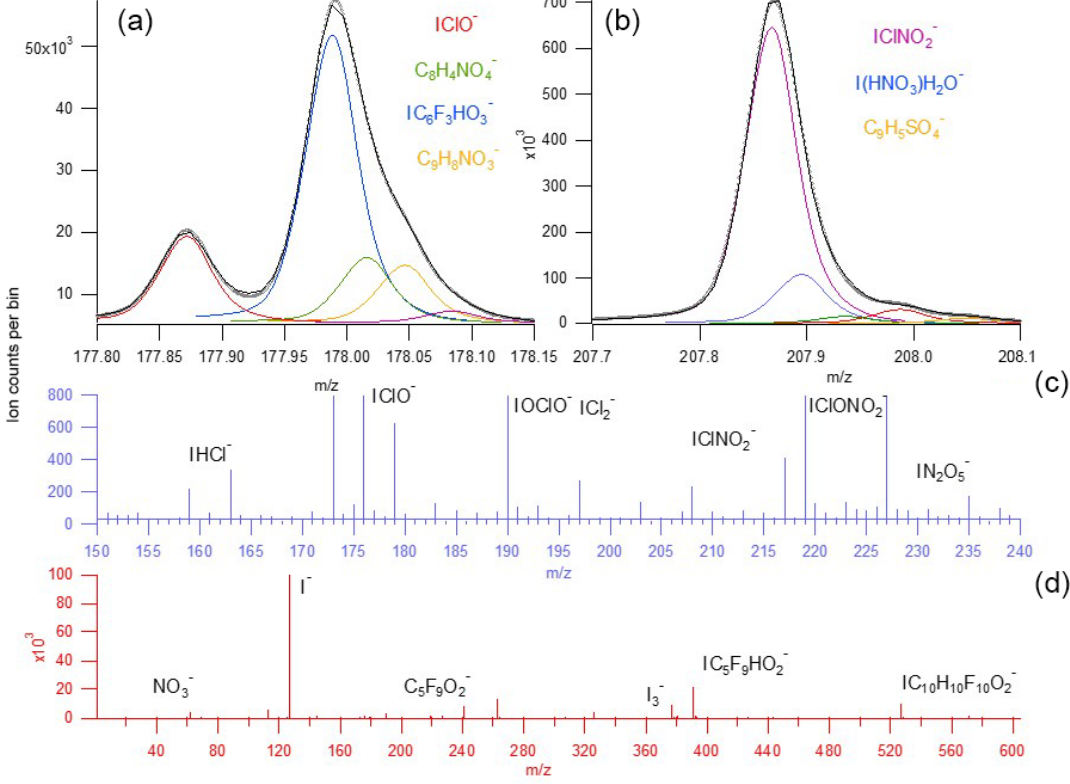
Figure 1. (a) Average mass spectrum for the whole measured range. (b) Average mass spectrum for the region that contains all gas-phase nighttime species utilised in this work. A high-resolution spectral fit for ClO and ClNO 2 is displayed with corresponding multi-peaks with 0.5 atomic mass units (AMU) ( c and d ). The black line represents the total fit from all peaks. The grey line represents the mass spectral raw